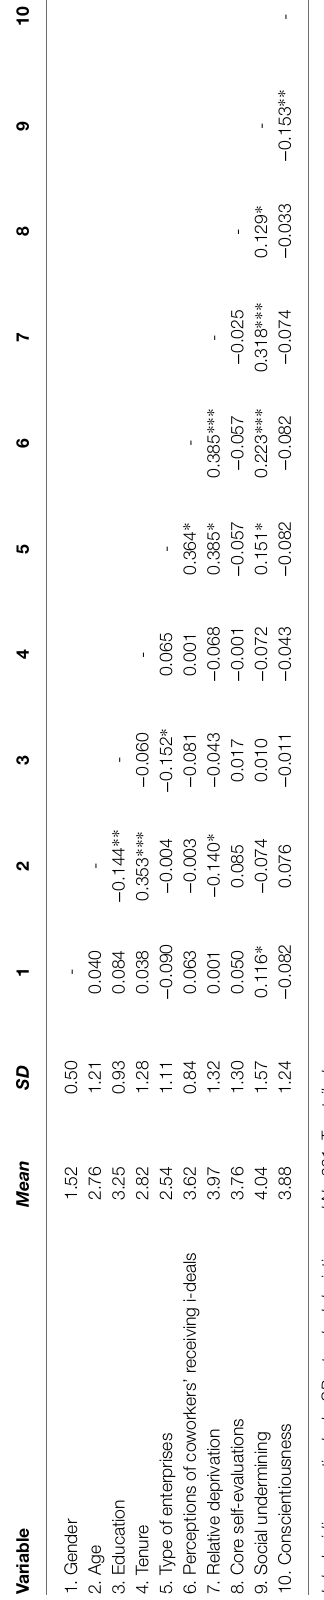
TABLE 3 | Bootstrapping results for moderating effect of W1 and W2. Path